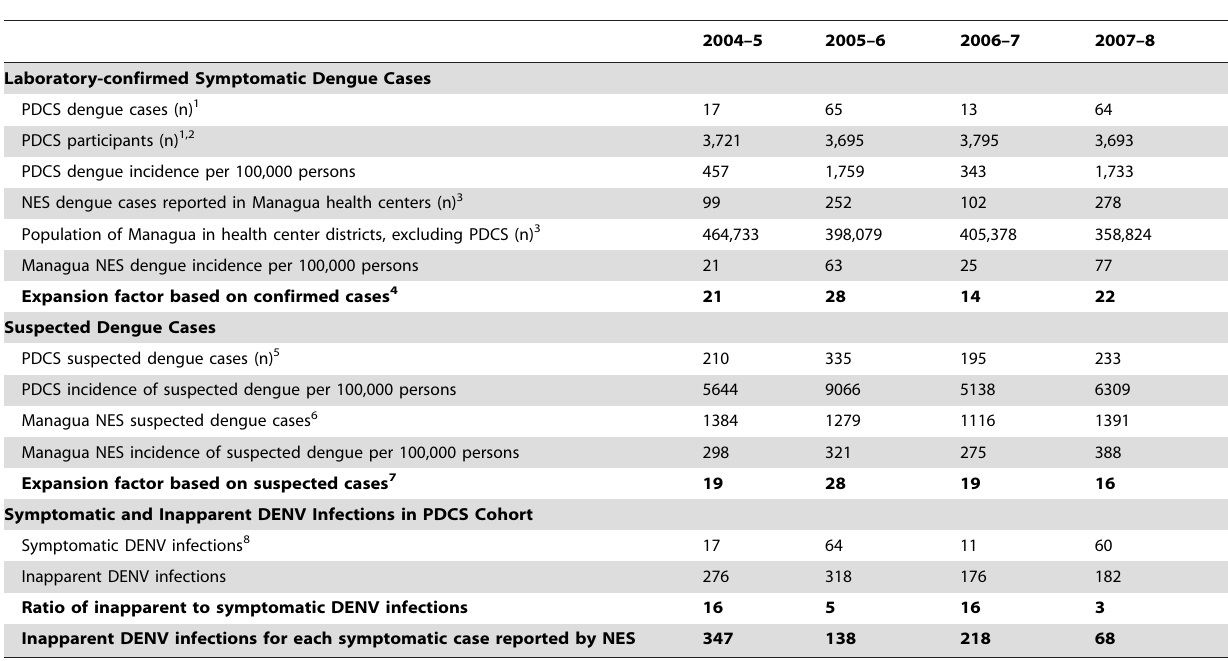
Table 1. Incidence of confirmed and suspected dengue cases and expansion